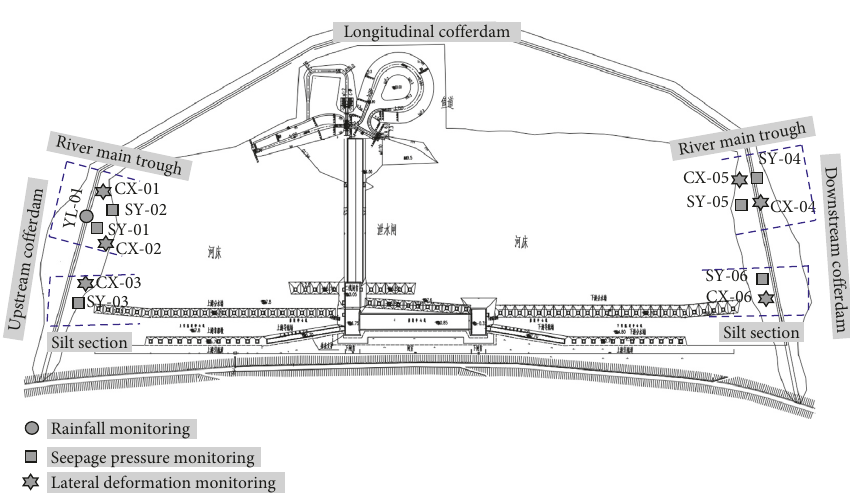
Figure 2: Schematic layout of cofferdam slope monitoring